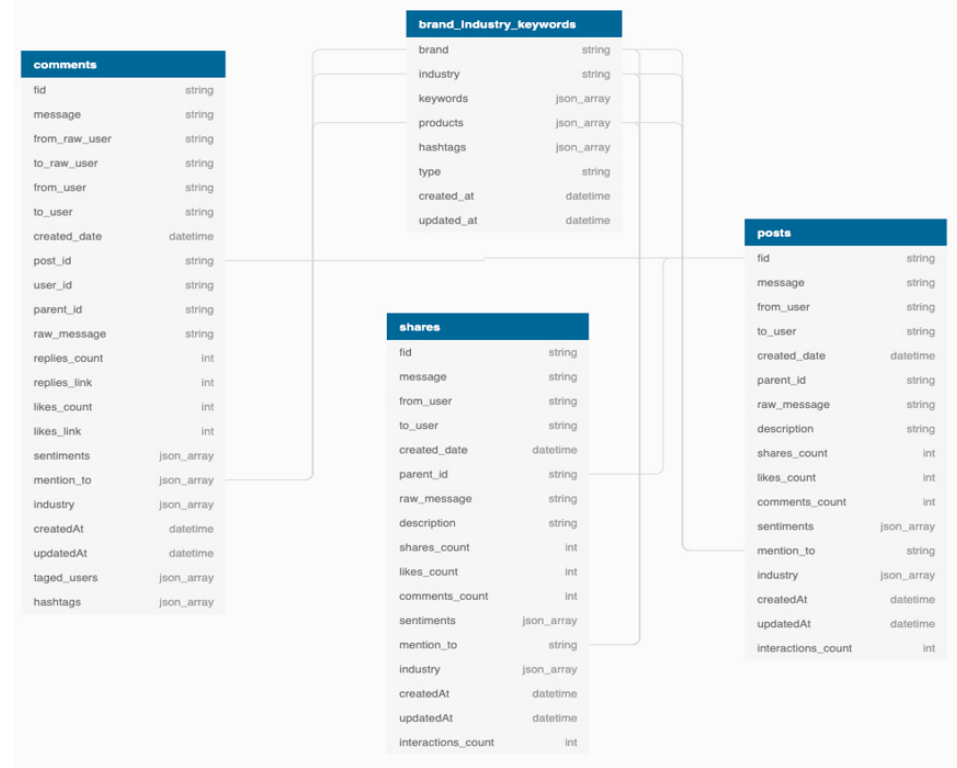
Figure 7. Preprocessed database schema.